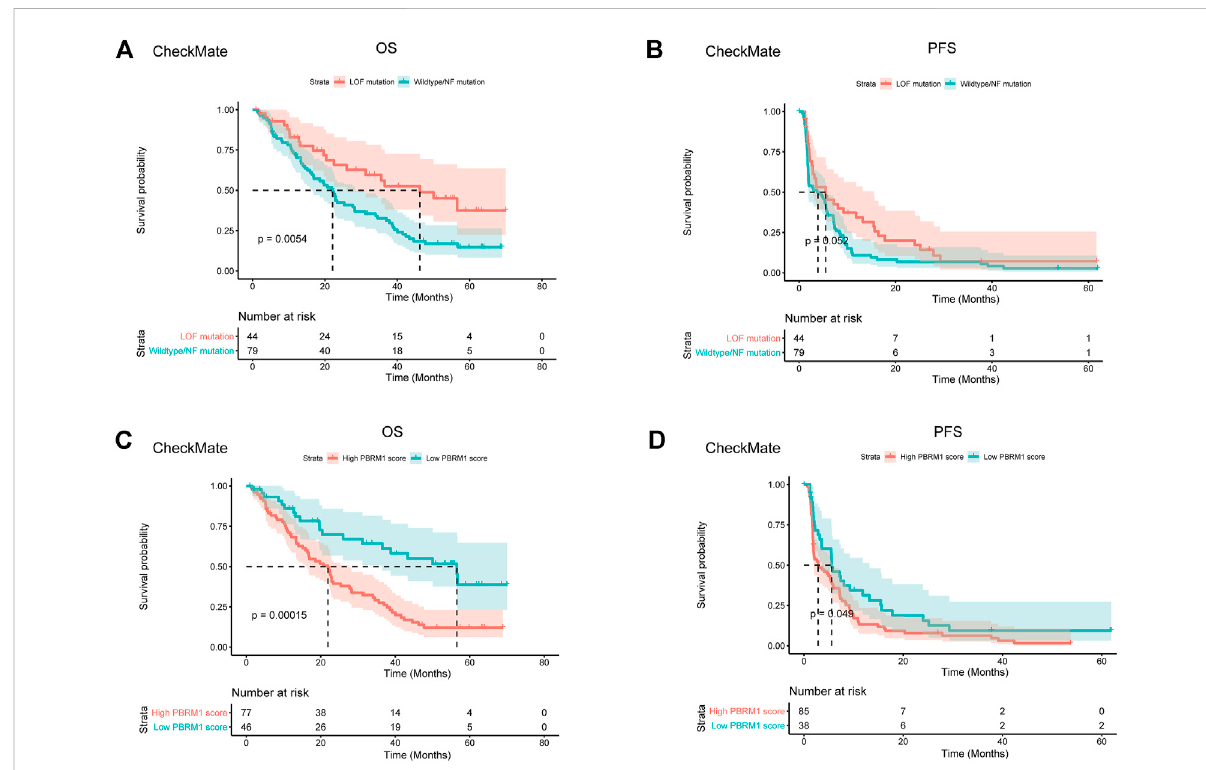
FIGURE 2 Integrated PBRM1 score outperforms both genomic and transcriptional variable of PBRM1. (A) The Kaplan-Meier curves of overall survival strati fi ed by loss of function or wildtype/normal function mutation of PBRM1 in the CheckMate 009, CheckMate 010 and CheckMate 025 datasets. (B) The Kaplan-Meier curves of progression free survival strati fi ed by loss of function or wildtype/normal function mutation of PBRM1 in the CheckMate 009, CheckMate 010 and CheckMate 025 datasets. (C) The Kaplan-Meier curves of overall survival strati fi ed by high or low integrated PBRM1 score in the CheckMate 009, CheckMate 010 and CheckMate 025 datasets. (D) The Kaplan-Meier curves of progression free survivalstrati fi edbyhighorlowintegratedPBRM1scoreintheCheckMate009,CheckMate010andCheckMate025datasets.LOFisshortforlossof function. NF is short for normal